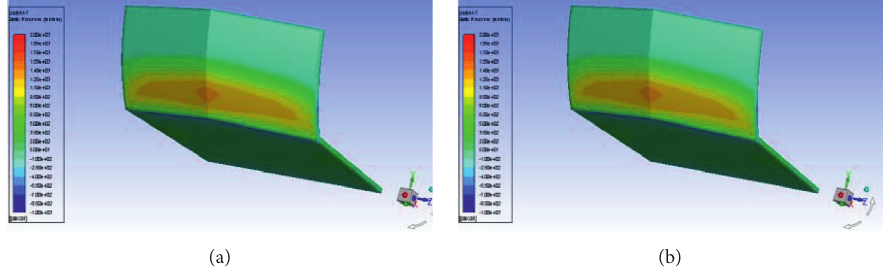
Figure 12: Pressure cloud diagram under different penetrating angles: (a) pressure cloud diagram when penetrating angle is 5 ° and (b) pressure cloud diagram when penetrating angle is 20 °